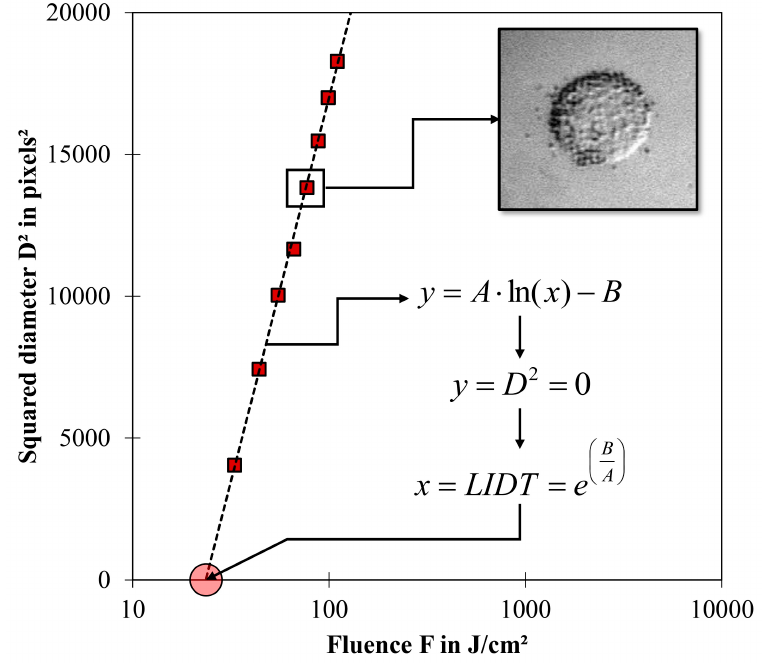
Figure 2. Principle of the diameter regression technique applied for the determination of the laser-induced damage threshold (LIDT) including an example for the observed damage morphology